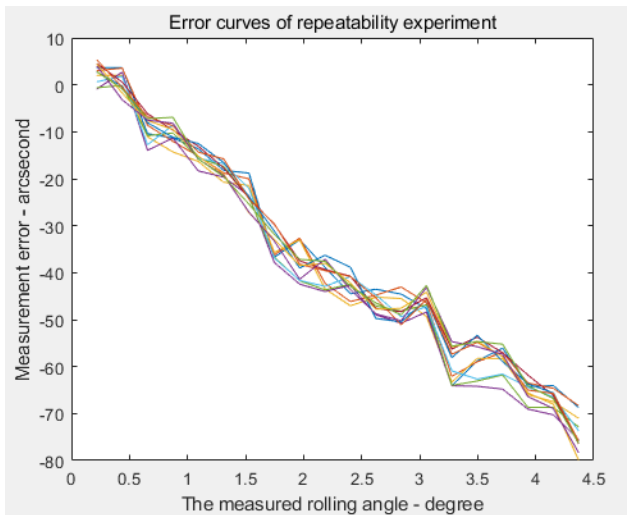
Figure 19. Repetitive error curves.